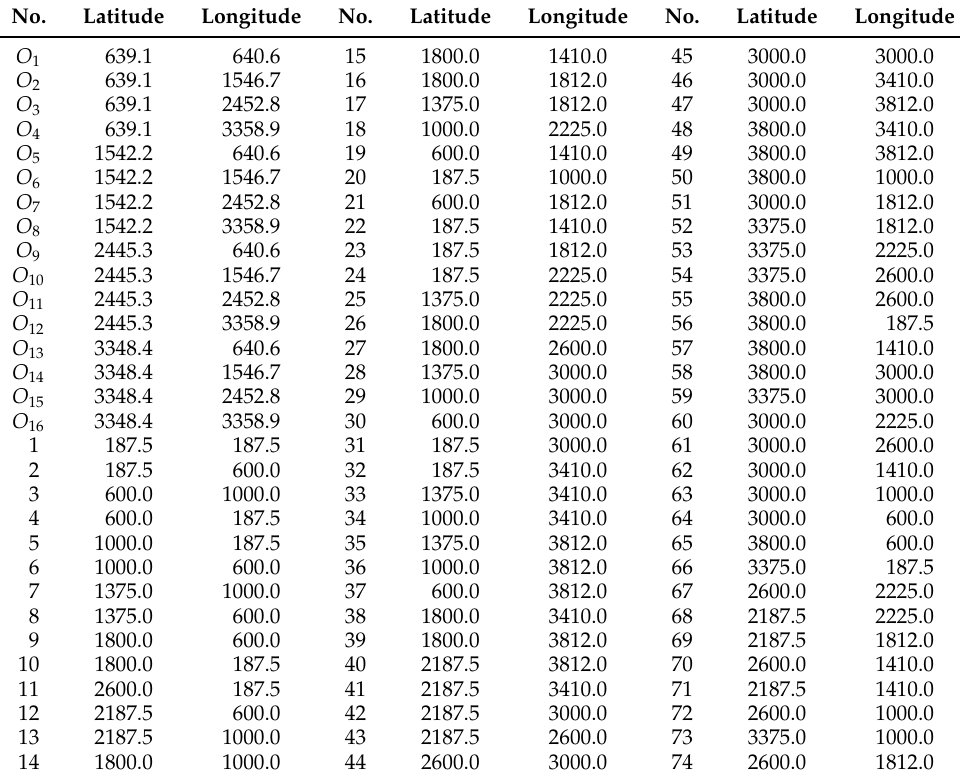
Table A2. WF-74-S3 wind farm coordinates